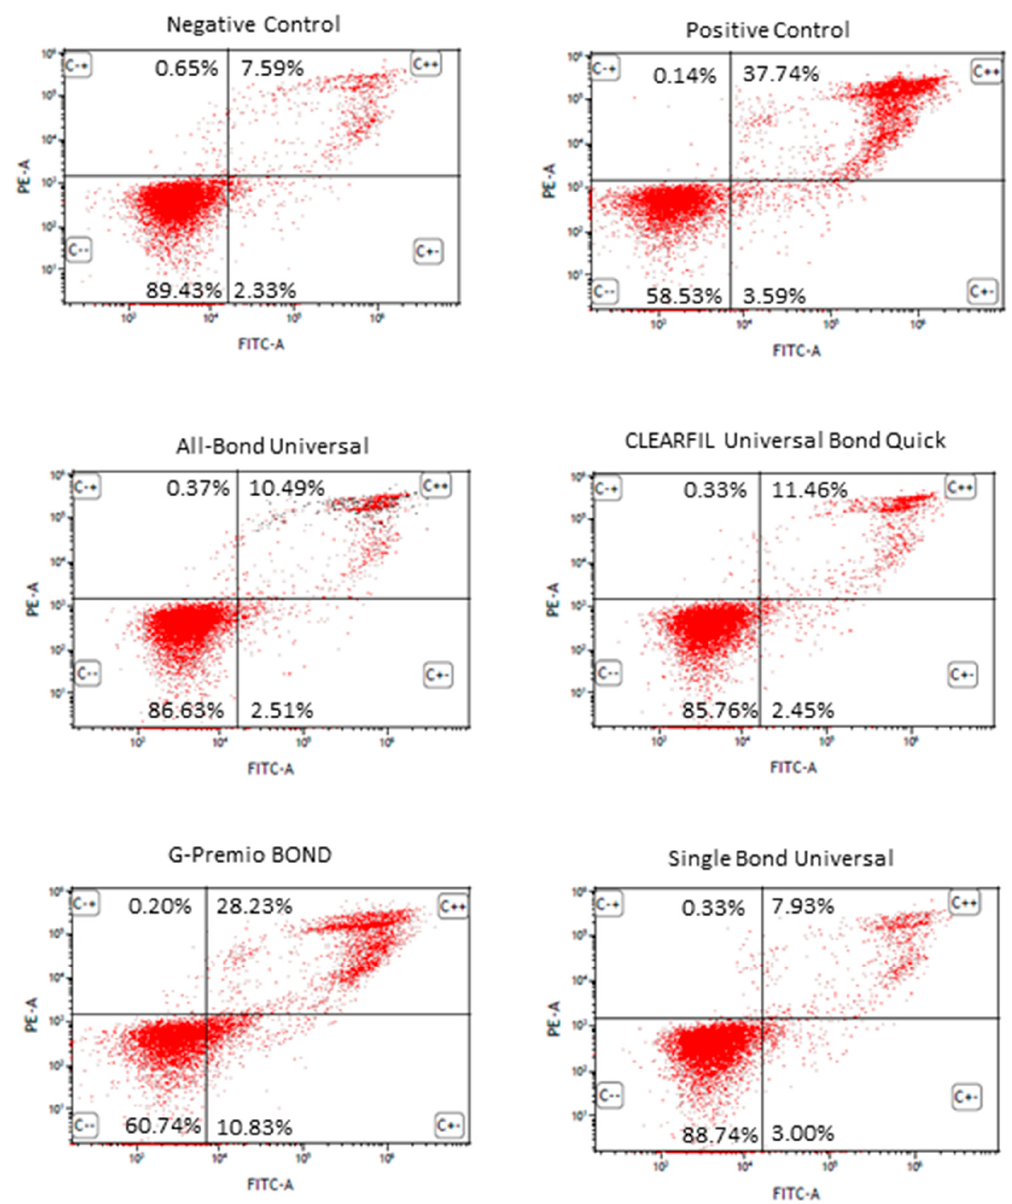
Figure 3. Flow cytometric FITC annexin V/propidium iodide (PI) double staining analysis of apoptosis after 24 h incubation of cells with the tested compounds. Dot plot graphs indicate the percentage of viable (FITC annexin V negative, PI negative), early apoptotic (FITC annexin V positive, PI negative) late apoptotic (FITC annexin V positive, PI positive) and necrotic (FITC annexin V negative, PI positive) cells. Cells treated with staurosporine at a concentration of 1 µM constituted a positive control. Cells suspended in the complete culture medium constituted a negative control.